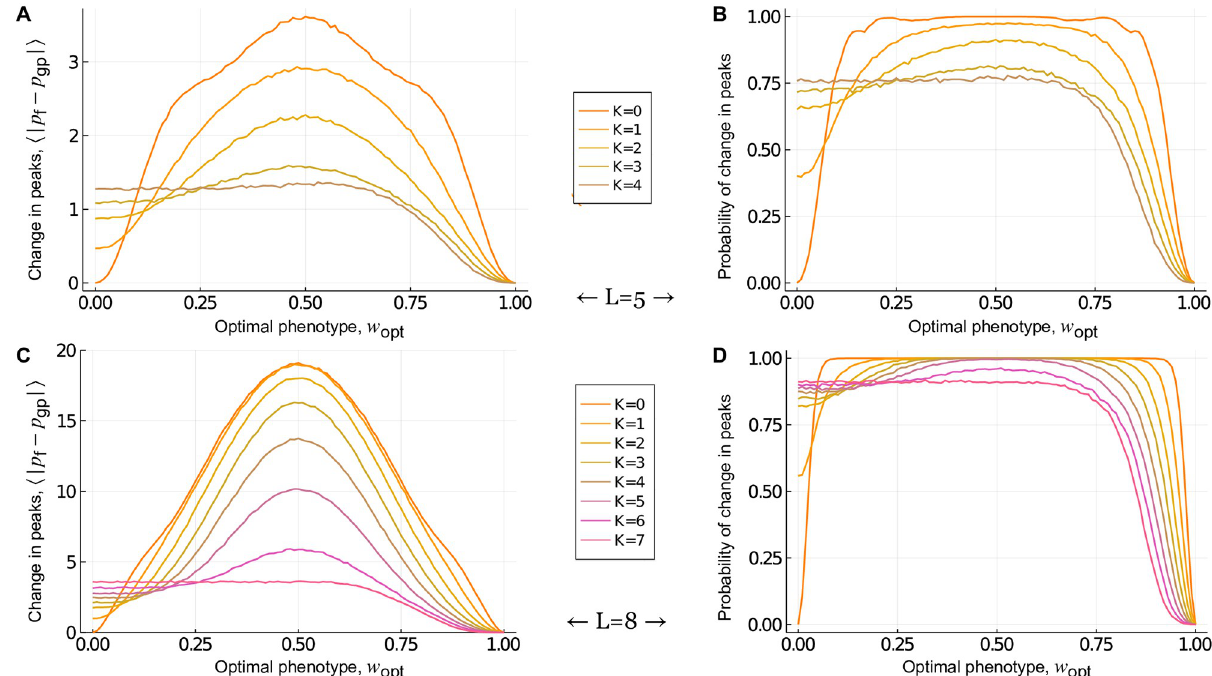
Fig 5. Global incongruence: NK genotype-phenotype landscapes. The absolute change in the number of peaks in the fitness landscape, relative to the genotype-phenotype landscape, is shown in relation to w opt for genotypes of length (A) L = 5 and (C) L = 8, as K increases from zero to L − 1. The corresponding probability of change in the number of peaks is shown in relation to w opt for genotypes of length (B) L = 5 and (D) L = 8, as K increases from zero to L − 1. These results are independent of σ , because they only depend on the rank ordering of fitness values.